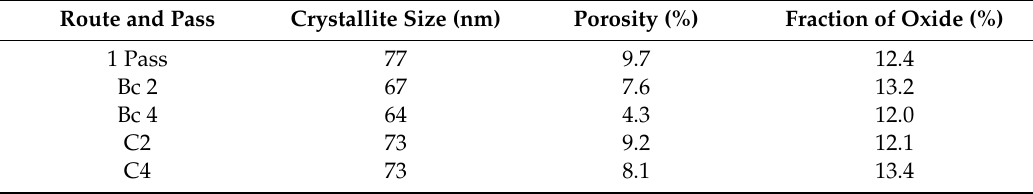
Table 3. XRD-calculated crystallite size of Mg, porosity and fraction of oxide in the ECAPed samples. Route and Pass Crystallite Size (nm) Porosity (%) Fraction of Oxide